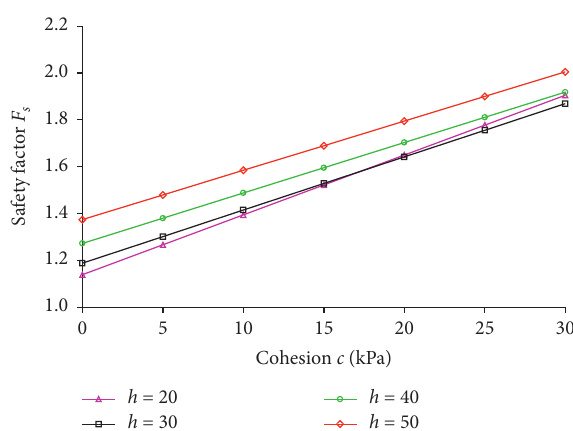
Figure 6: Relationship between the safety factor and cohesion of the weak interlayer.